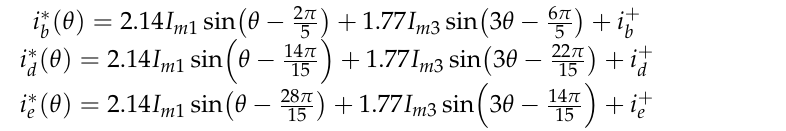
Figure 5. I-power graphs for the adjacent double-phase OCFT condition currents: ( a ) Fundamental; ( b ) fundamental plus third harmonic.